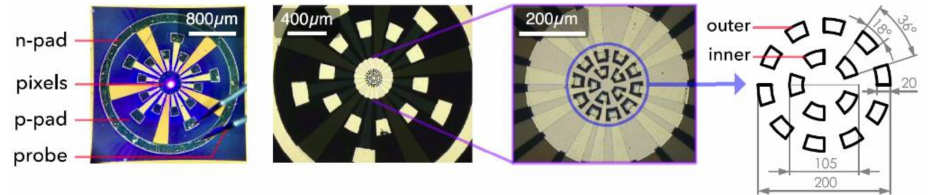
Figure 5. Micro-LEDs proposed in Ref. [28]. Reproduced with permission from [28], Chinese Laser Press, 2017. (Reprinted from Photonics Research, 5, Islim, M. etc., Towards 10 Gb/s OFDM-based visible light communication using a GaN violet micro-LED. A35-A43, Copyright (2017), with permission from Chinese Laser